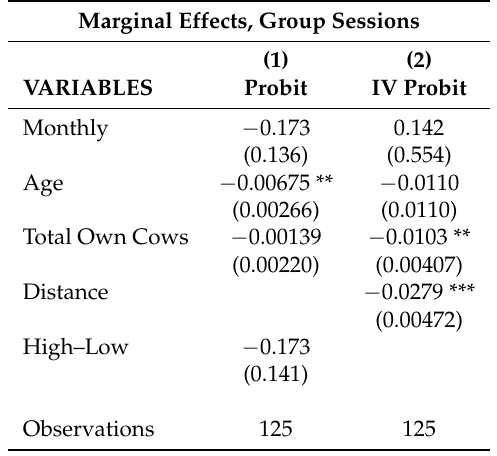
Table 7. Effect of Distance on Uptake of Group versus Individual